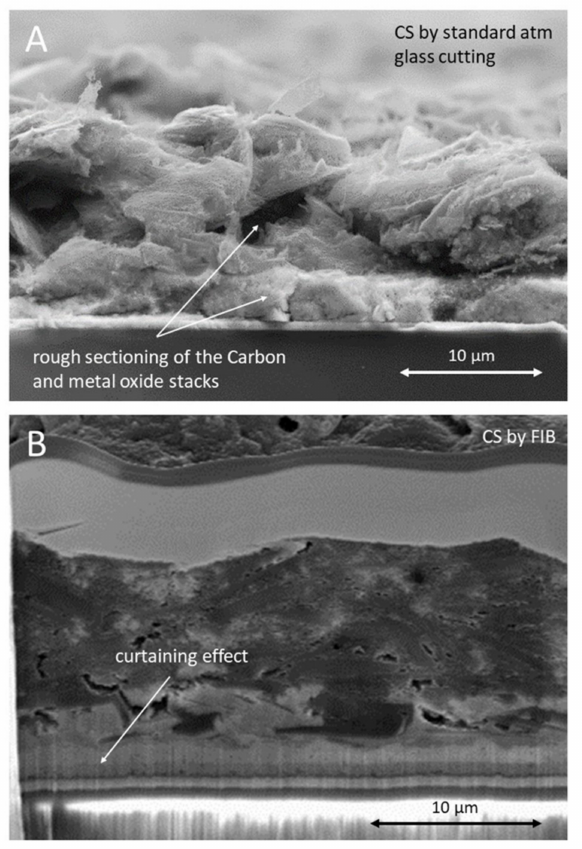
Figure 1. SEM observation of cross sections of the carbon triple stack prepared by application of: ( A ) atmospheric glass cutting vs. ( B ) focused ion beam milling. The procedures are briefly described in Section